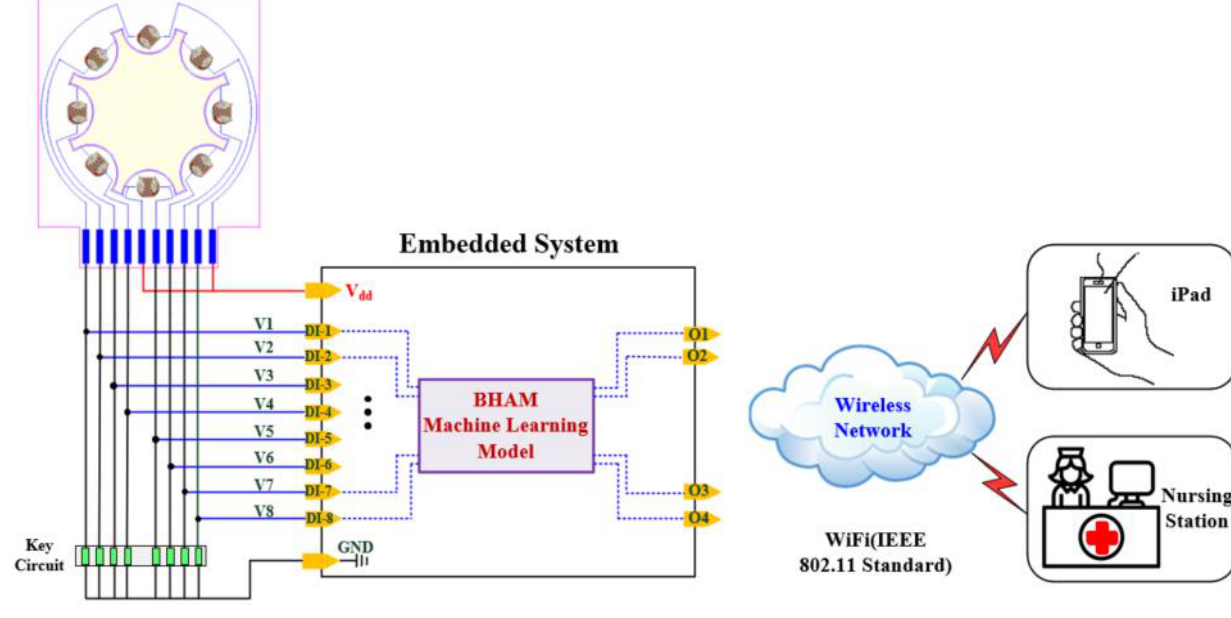
Figure 3. Structure of integrated flexible ring-light sensor array and machine learning model.